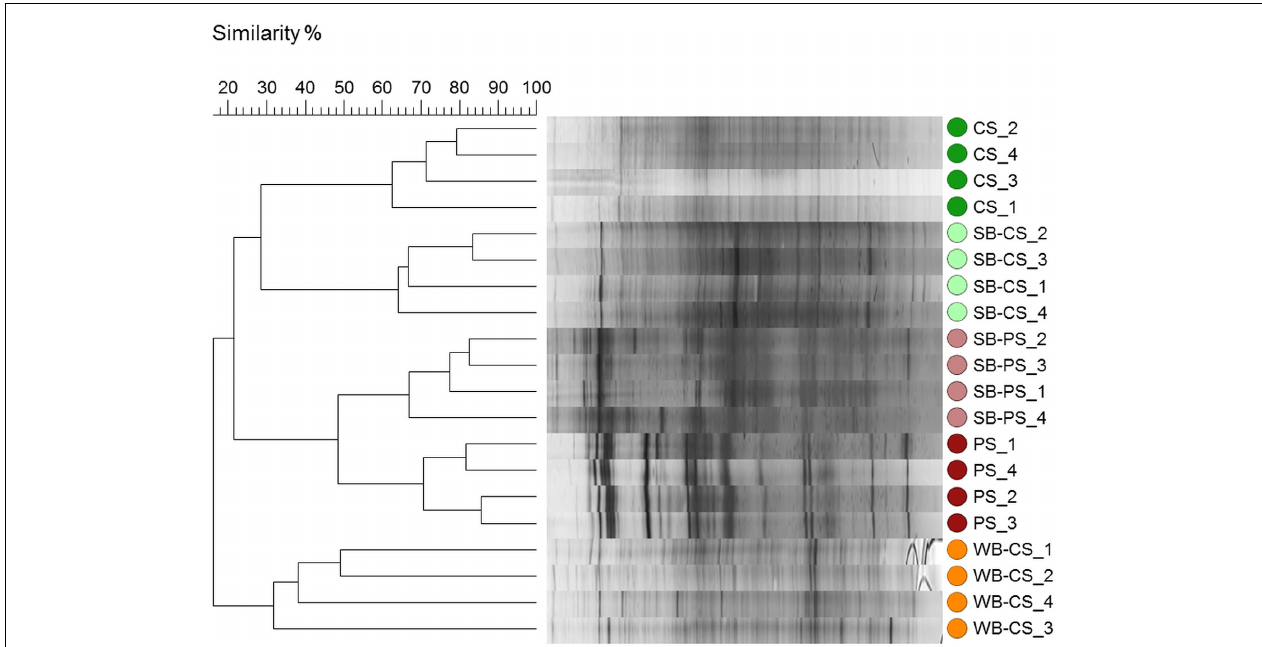
FIGURE 1 | Dendrogram of 16S rRNA gene-based SSCP profiles of bacterial communities in association with wild beet (WB-CS) and sugar beet rhizosphere grown in coastal drift line (SB-CS) and potting soil (SB-PS) and their respective bulk soils (CS, PS) with